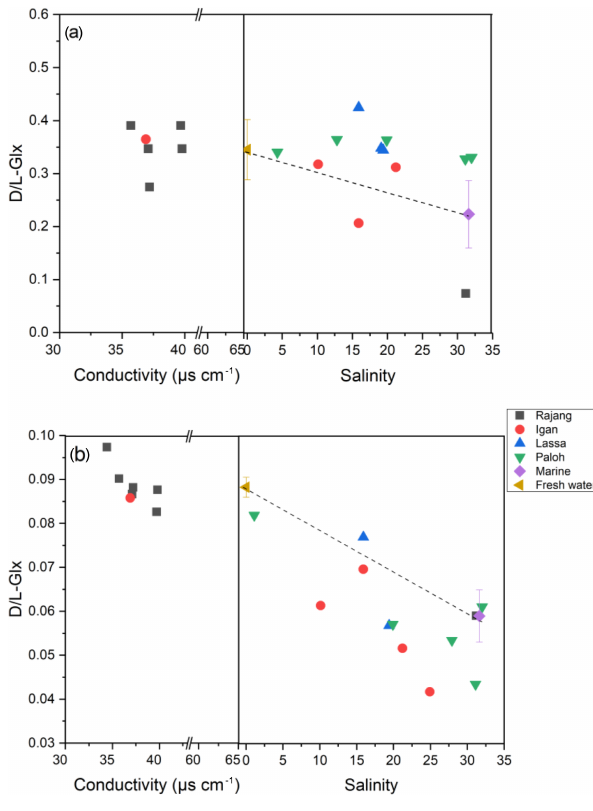
Figure 5. The D- / L-Glx distribution pattern from fresh water to the estuary in the Rajang: (a) dissolved and (b) particulate. Note the different x -axis scales between plots (a) and (b) . The dashed line indicates the linear mixing line between freshwater and marine endmembers. The freshwater endmember (brown triangle) was cal- culated as the mean of all freshwater samples (salinity 0), and the marine endmember (purple diamond) was calculated as the mean of all offshore samples with salinity > 30. The error bar indicates the standard